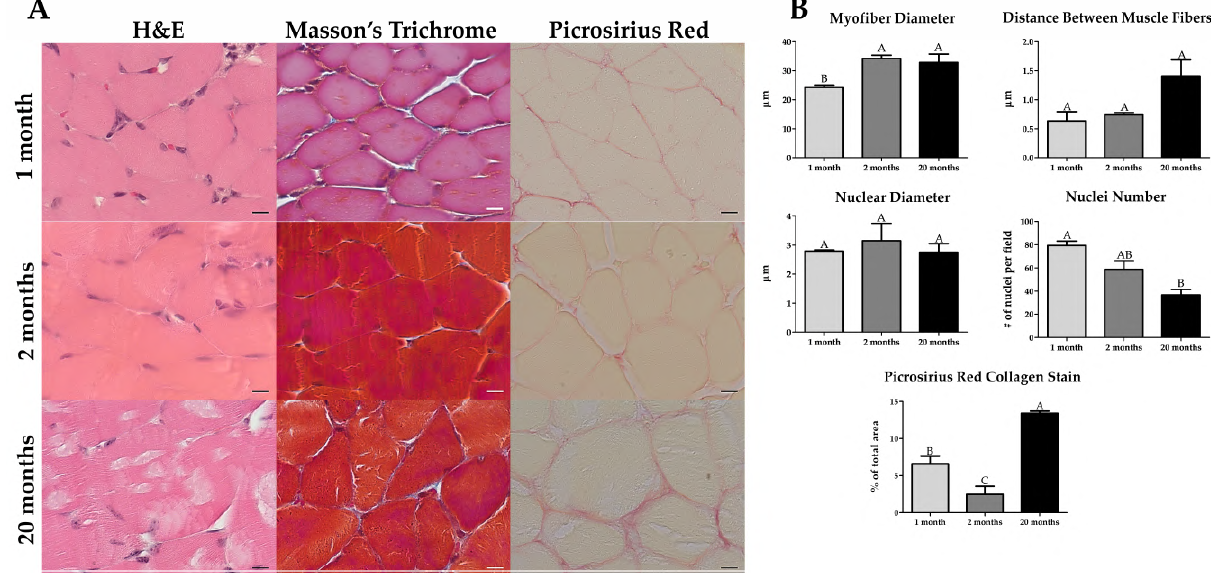
Figure 1. The gastrocnemius shows histomorphometric differences in old age. ( A ) Hematoxylin and Eosin (H&E) staining ( n = 3) revealed a reduction in nuclei and the presence of lipofuscin ‐ like or tubular aggregates inside the muscle fibers with old age. Masson’s Trichrome ( n = 3) had no apparent differences with age. Picrosirius Red staining ( n = 4) displayed a pronounced increase in collagen staining in old age. ( B ) When quantified histomorphometrically, the gastrocnemius had a smaller myofiber diameter in immature muscle, an increase in the distance between muscle fibers and a decrease in the number of nuclei in old age, and a bimodal amount of collagen staining where immature and old have higher levels of collagen than young adult, albeit older also has higher amounts than immature muscle. Scale bar = 10 μ m. Groups that do not share a letter (e.g. A, B, or C) are statistically different according to a one ‐ way ANOVA followed by a two ‐ tailed Tukey’s correction ( p < 0.05, n = 3 for H&E and Masson’s, n = 4 for Picrosirius Red).